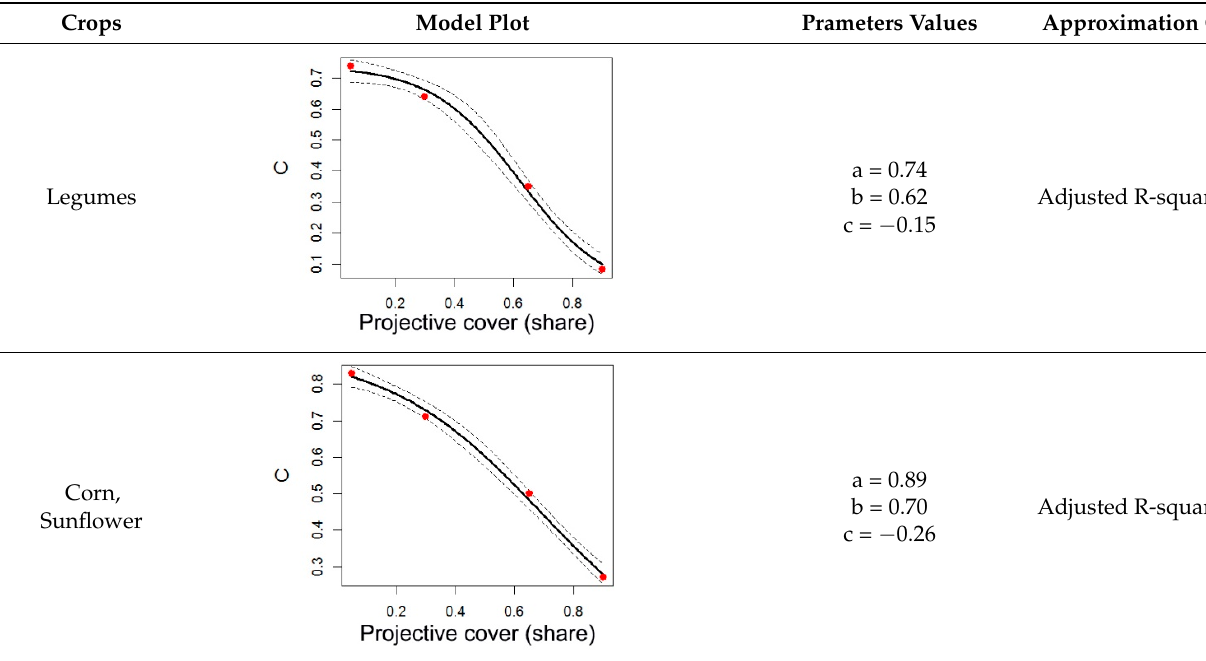
Table 4. Results of mathematical approximation of the dependence of the erosion indices of crops on the projective cover for 4 periods of the warm part of the year (from the beginning of the vegetation season to harvesting, 2–5 periods) using the sigmoid.